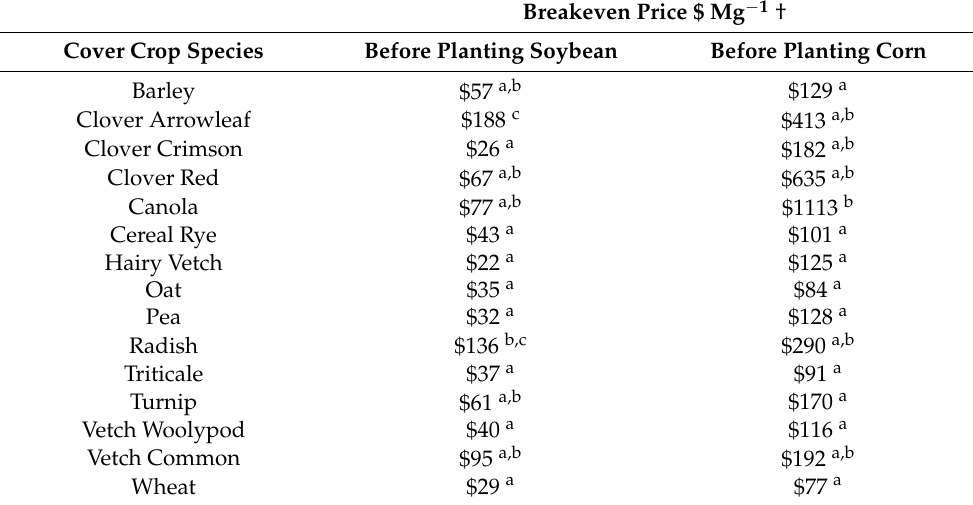
Table 6. Breakeven forage price for cover crop hay harvest before planting corn and soybeans across cover crop species in $ Mg − 1 ( n =